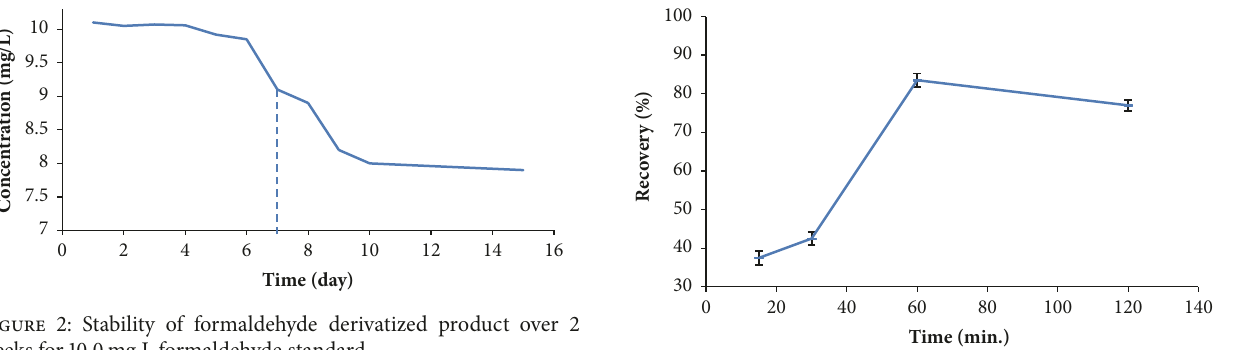
Figure 4: Effect of various times of formaldehyde incubation reac- tion recovery (mean ± sd, n =